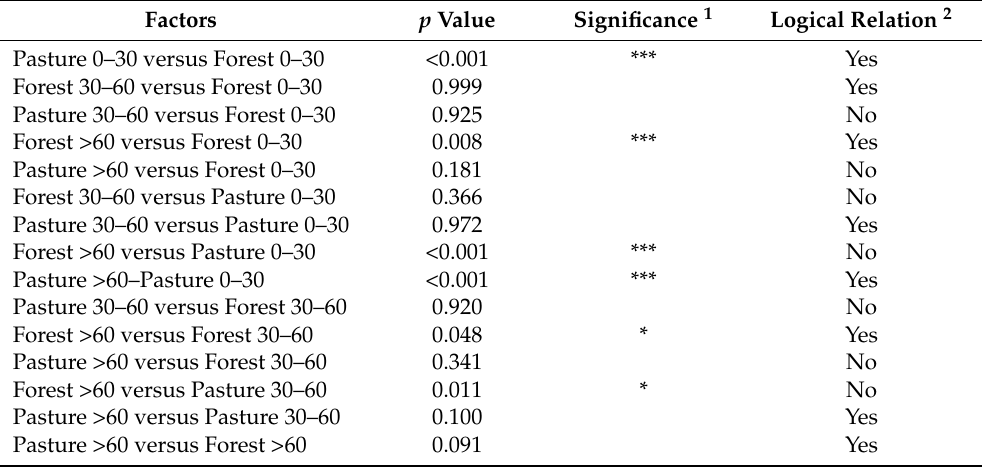
Table 3. Analysis of general linear hypotheses (GLHs) to compare the significant differences between multiple factors. Factors p